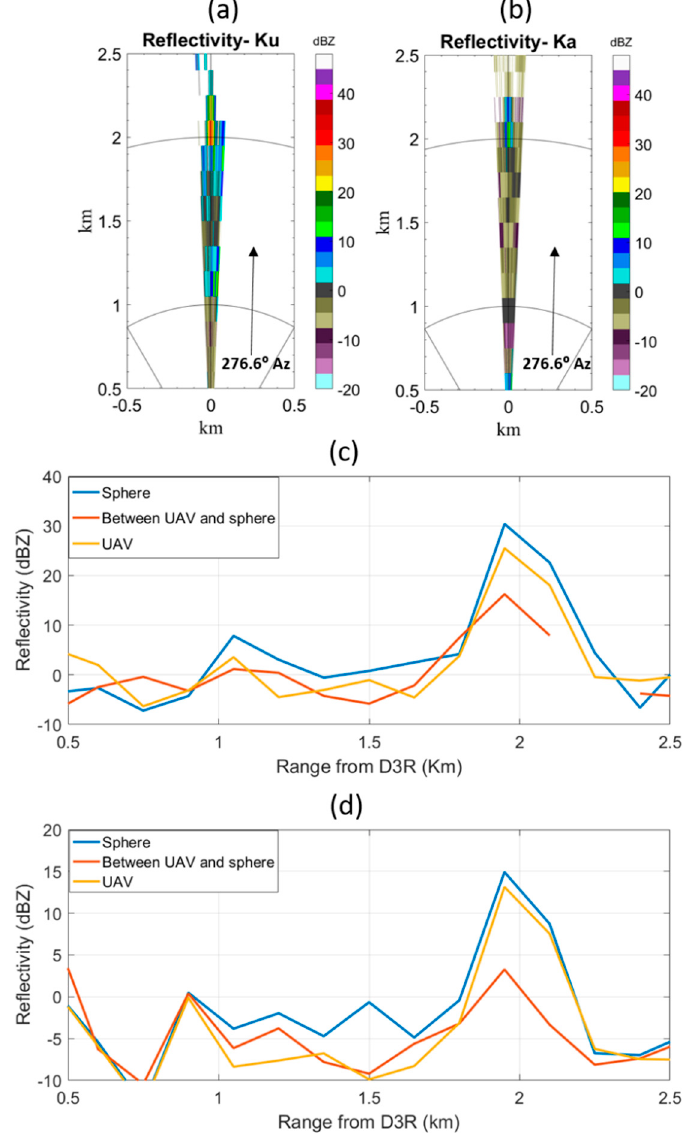
Figure 6. D3R Ku and Ka data for the calibration experiment. ( a ) PPI plot of Ku data corresponding to the sphere; ( b ) PPI plot of the Ka data corresponding to the sphere; ( c ) line plots of reflectivity at 276.6 degree azimuth for Ku data; and ( d ) line plots of reflectivity at 276.6 degree azimuth for Ka data.